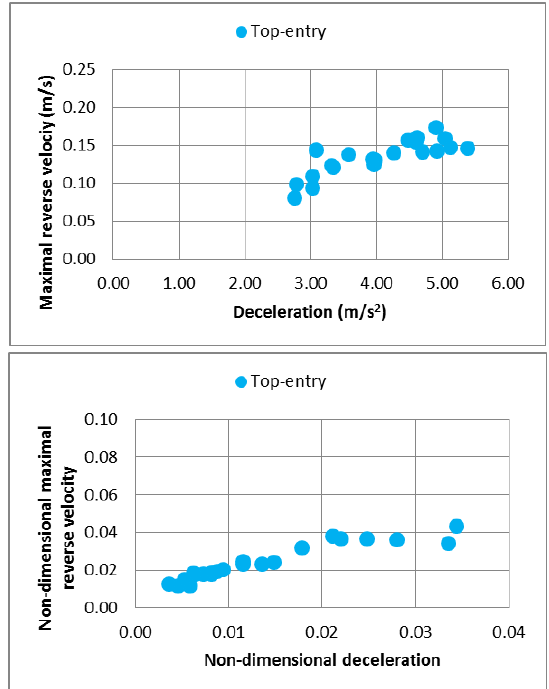
Fig. 14. Dynamic properties – reverse velocity dependence on system deceleration